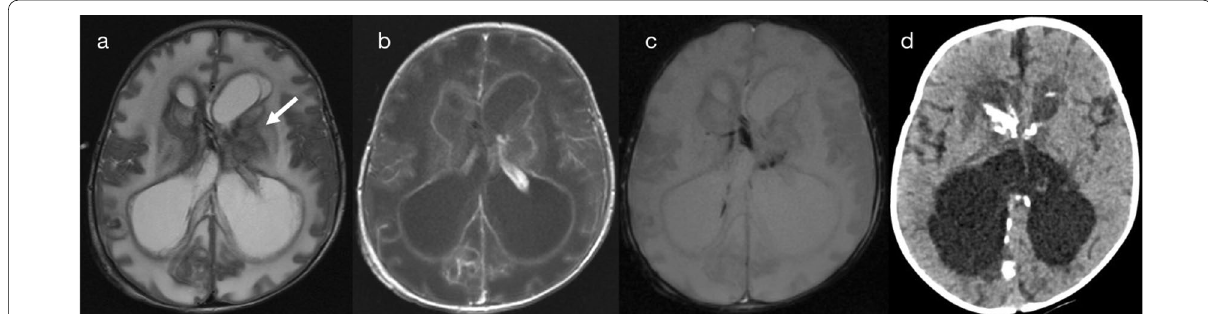
Fig. 10 T2 hyperintensity in supratentorial white matter—with neuronal migration abnormality (Pattern 4A). 4‑week‑old infant with seizures, irritability and bulging fontanelles. CSF analysis was consistent with neurotoxoplasmosis. T2‑weighted imaging ( a ) demonstrated diffuse white matter hyperintensity, widespread abnormal cortical development and hydrocephalus. Lesions were seen throughout the cerebral hemispheres, in the periventricular regions (arrow), basal ganglia and the thalami. Post‑contrast T1‑weighted imaging ( b ) demonstrated peripheral enhancement of parenchymal lesions, and ependymal enhancement in the lateral ventricles (reflecting ventriculitis). On a T2*‑weighted sequence ( c ), foci of susceptibility artefact corresponded to areas of haemorrhage and calcification (secondary to parenchymal necrosis). Non‑contrast CT head performed 5 months later ( d ) better demonstrated regions of periventricular calcification